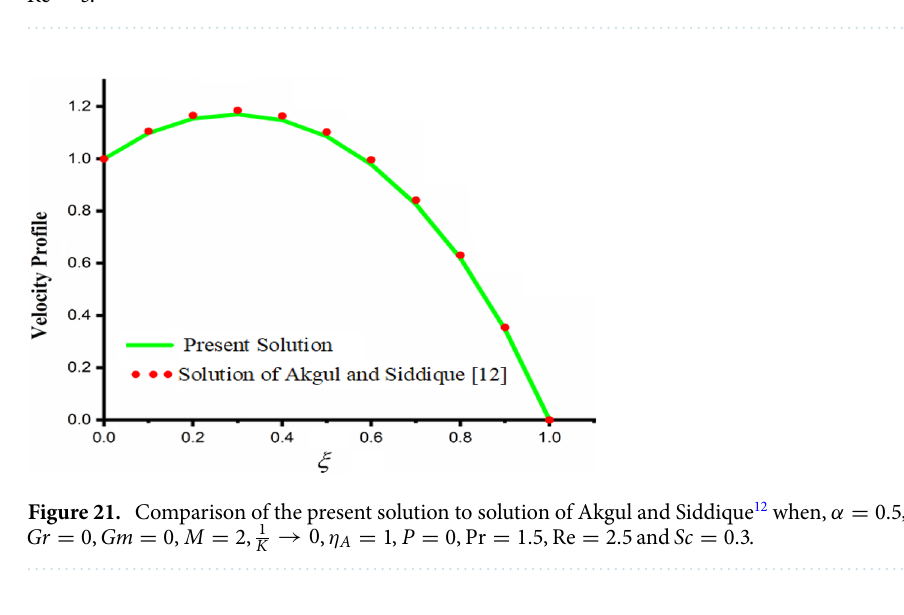
Figure 20. The impact of Sc on couple stress fluid concentration profile when, α = 0.5 , β = 0.5 , t = 0.2 and Re = 3 .